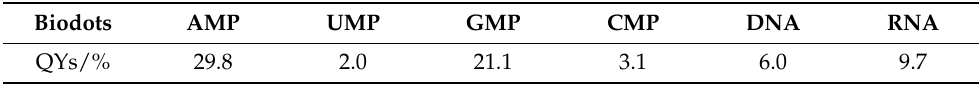
Figure 7. Comparison of fluorescent properties of biodots. ( A ). Fluorescence spectra of 0.033% ( w / v ) solutions of biodots prepared from DNA, RNA, UMP, CMP and 0.0066% ( w / v ) solutions of biodots prepared from AMP and GMP at different excitation wavelengths λ ex = 275–400 nm. Note that concentrations of AMP and GMP used for fluorescence measurements are lower. ( B ). Dependences of maximum fluorescence emission wavelengths ( λ em ) and fluorescence intensities of biodots on excitation wavelength ( λ ex ). Values of measured fluorescence intensities are shown above the circles in which the areas are proportional to the fluorescence intensities. Table 2. Quantum yields (QYs) of nucleic acid